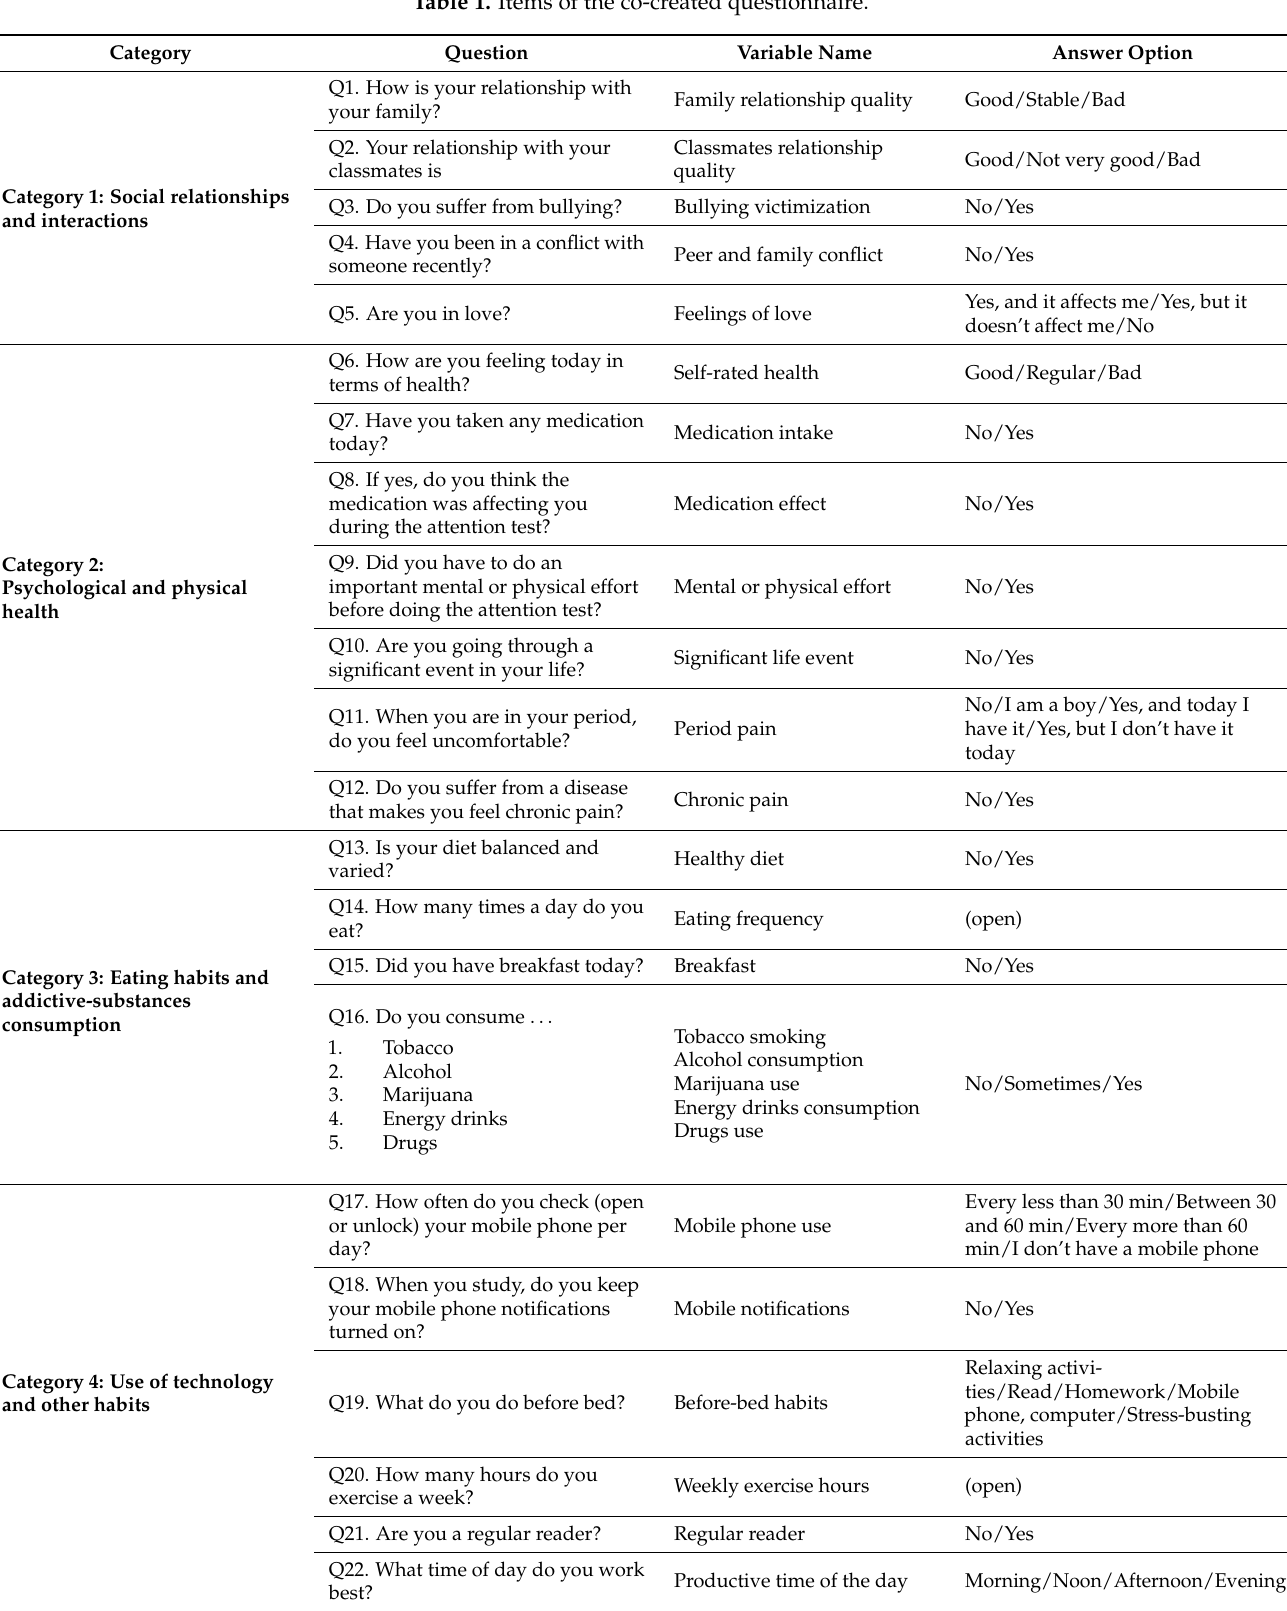
Table 1. Items of the co-created